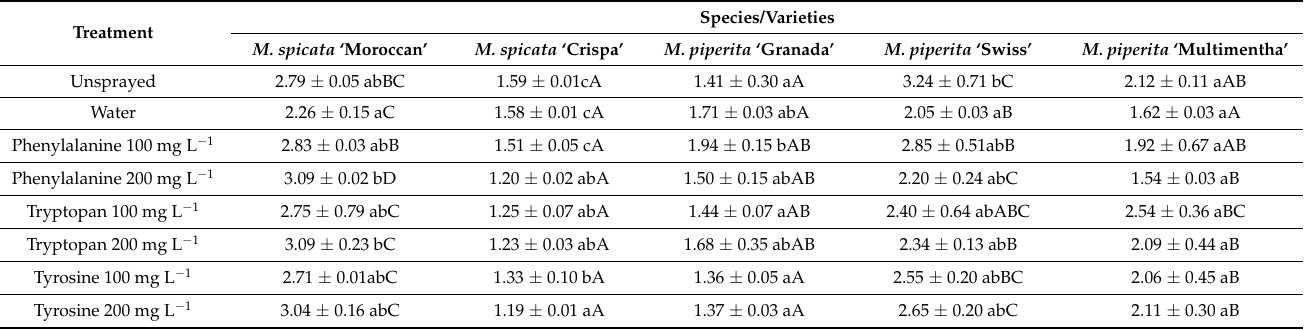
Table 1. Essential oil content in mint influenced by foliar application of amino acids, mg 100 g − 1 DM in 2017–2018.